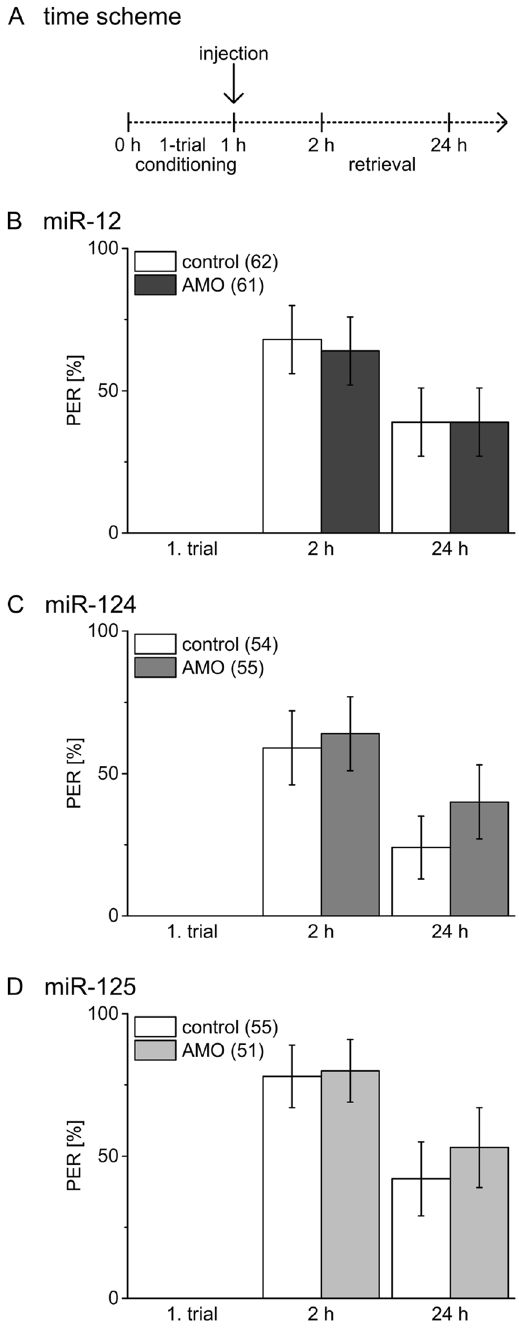
Figure 3. Inhibition of miRNAs after 1-trial conditioning does not affect early memory. ( A ) Bees were injected 1 h after 1-trial conditioning with inhibitors (AMO) for miR-12 ( B ), miR-124 ( C ), miR-125 ( D ) or PBS (control). Columns show the percentage of bees reacting with PER to odour presentation during conditioning and retrieval tests 2 h and 24 h after conditioning. The error bars indicate 95% binominal confidence interval and the numbers of tested animals per group are indicated in brackets. There were no significant differences (Chi-square/Fisher exact test (two-tailed) p > 0.05 details in